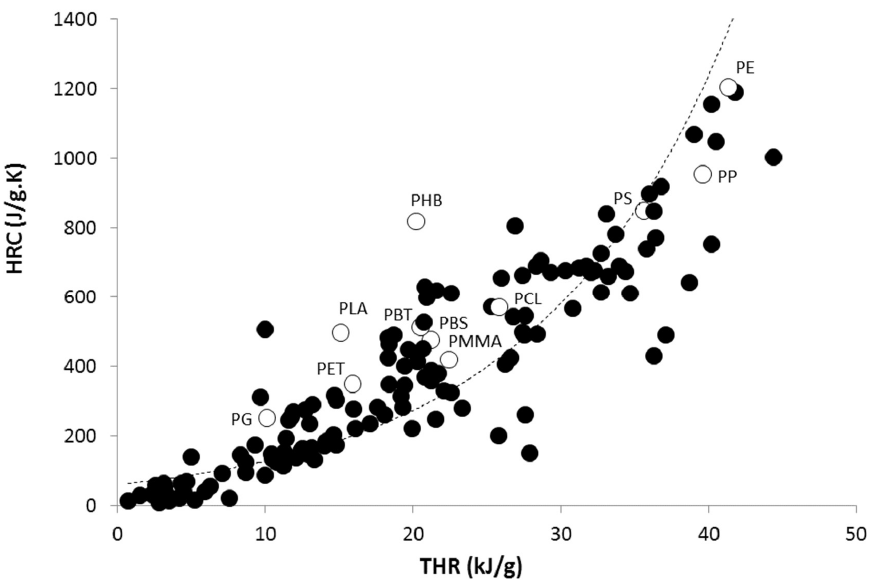
Figure 2 – Correlation between heat release capacity and total heat release measured in PCFC for Figure 2. Correlation between heat release capacity and total heat release (THR) measured in a pyrolysis-combustion flow calorimeter (PCFC) for around 150 pure polymers (data drawn from [4]). around 150 pure polymers (data drawn from [SON16]) White circles correspond to the 11 polymers studied in this